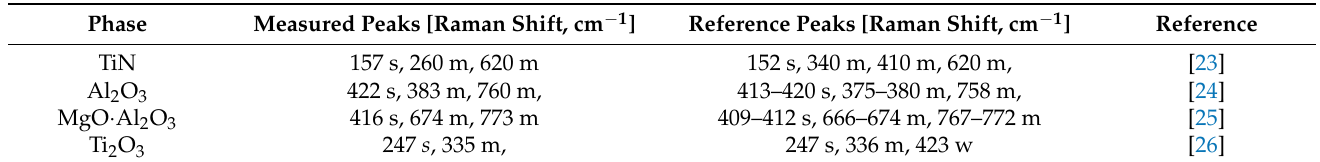
Table 3. Measurement Raman peaks (bands) for the synthetic phase used for this study (where s is strong, m is medium, and w is weak).